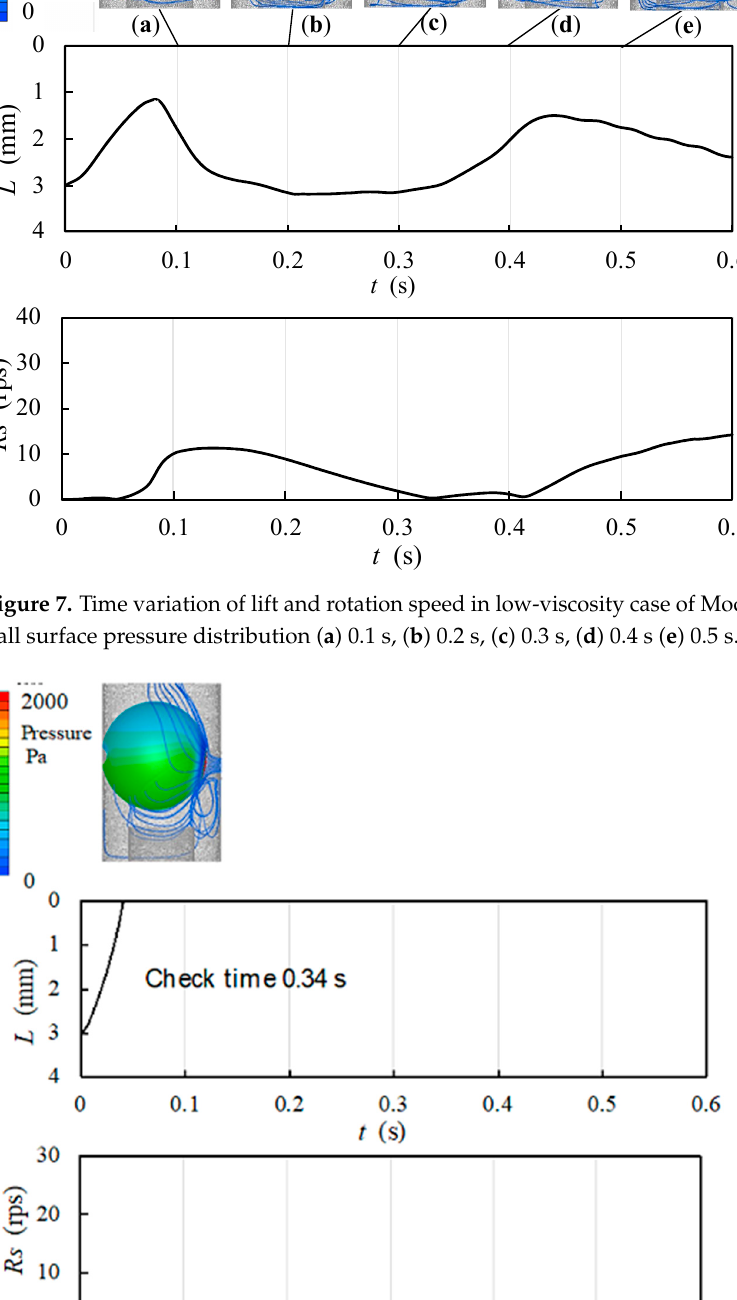
Figure 9. Time variation of lift for low-viscosity case with three degrees of freedom of Model (b); Streamlines and ball surface pressure distribution ( a ) 0.1 s, ( b ) 0.2 s, ( c ) 0.3 s, ( d ) 0.4 s ( e ) 0.5 s. 3.3. Effect of Inlet Diameter on Ball Rotation and Translational Motion To clarify the relationship between the flow velocity and the rotational force of the ball, CAE analysis was also carried out for Model (c), wherein the inlet diameter was the same as the outlet diameter (5 mm). However, because the diameter of the inlet was in- creased by a factor of 2.5, the flow rate was increased by a factor of 2.5 to maintain the same Reynolds number. The results of the analysis revealed that, even with the same Reynolds number, the check balls did not rise to the surface in either the low- or the high- 0 1 2 3 4 0